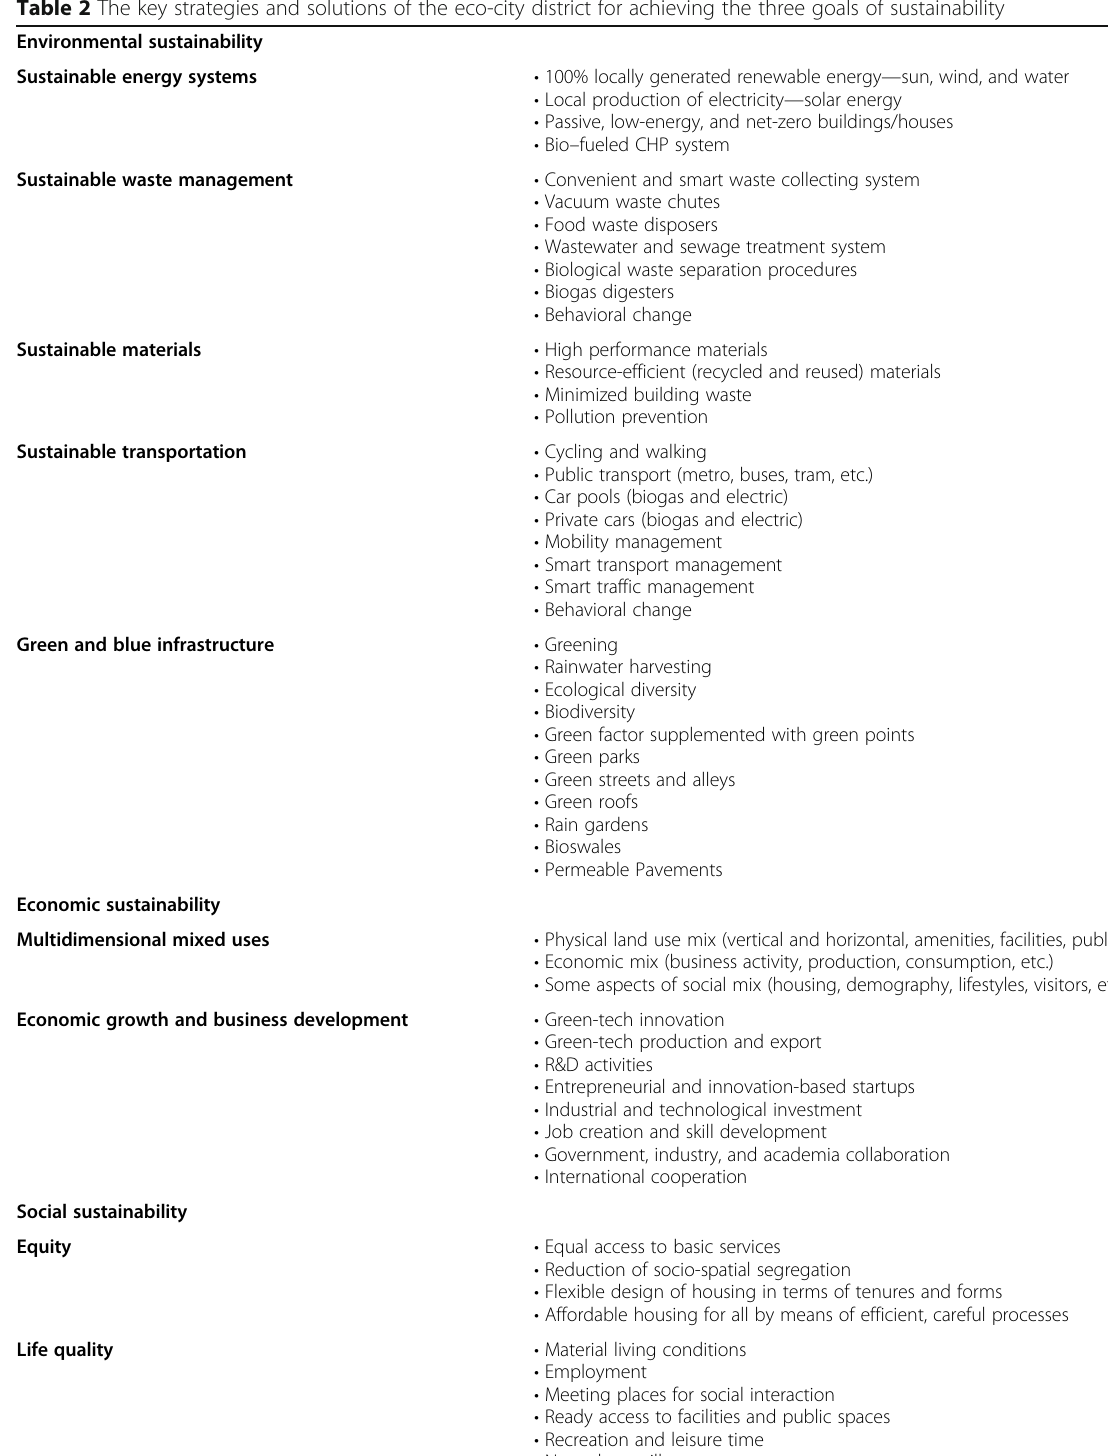
Table 2 The key strategies and solutions of the eco-city district for achieving the three goals of